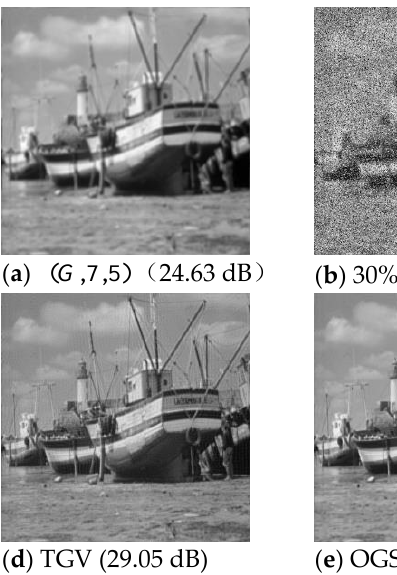
Figure 6. Comparison of the visual effects and PSNRs of image restorations of the “Boat” image degraded with a Gaussian blur kernel ( G ,7,5 ) and 30% impulse noise: ( a ) blurred image; ( b ) blurred image with 30% impulse noise; ( c ) fast total variation deconvolution (FTVd)-restored image; ( d ) total generalized variation (TGV)-restored image; ( e ) overlapping group sparsity total variation (OGSTV)-restored image; ( f ) proposed algorithm-restored image.